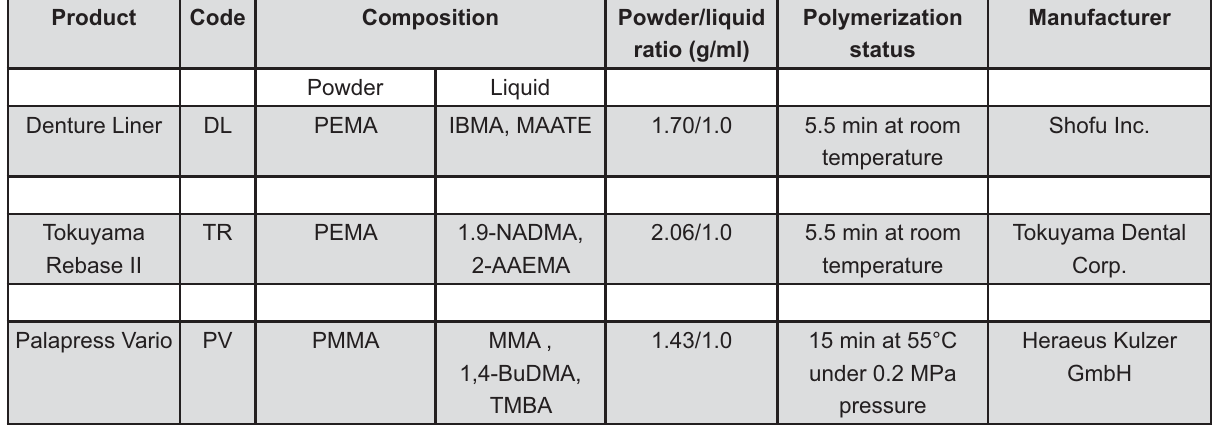
PEMA=poly(ethyl methacrylate); IBMA=isobutyl methacrylate; MAATE=methacrylic acid triester; 1,9-NADMA=1,9- nonanediol dimethacrylate; 2-AAEMA=(acetoacetoxy) ethyl methacrylate, MMA=methyl methacrylate, 1,4-BuDMA=1,4- butanediol dimethacrylate. TMBA=trimethyl barbituric Figure 1- Resin materials used in this study